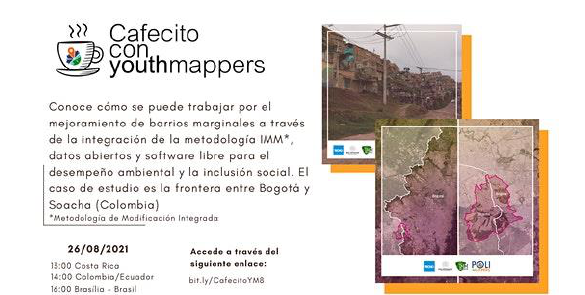
Figure8 . Flyer of event organized by Semillero Geolab